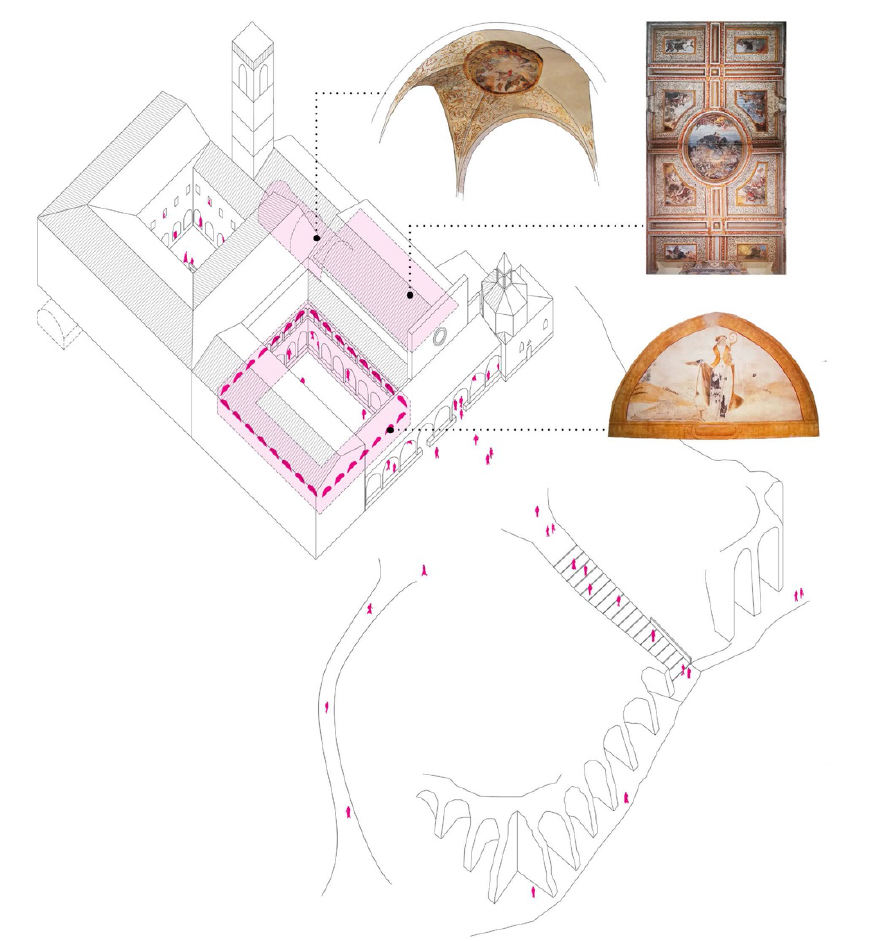
• Phase 4 corresponds to 1494–1514. At the beginning of the sixteenth centuries, the Friars Minor expanded the monastery, raising and lengthening the existing spaces. In the middle of the sixteenth century,